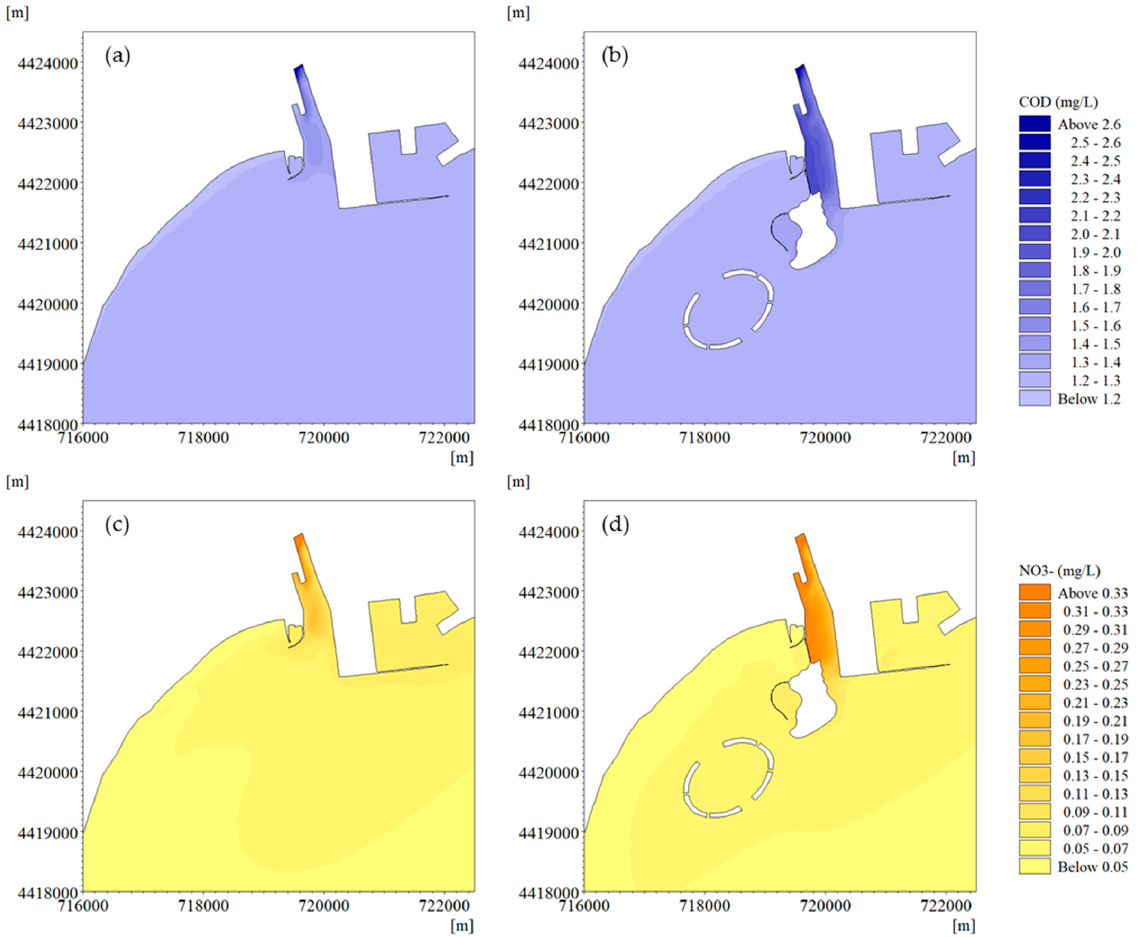
Figure 12. Average concentration of COD during a spring tidal period under ( a ) the initial construc- tion conditions, ( b ) the first-stage construction conditions and averaged concentration of NO 3 − dur- ing a spring tidal period under ( c ) the initial construction conditions, ( d ) the first-stage construction conditions.